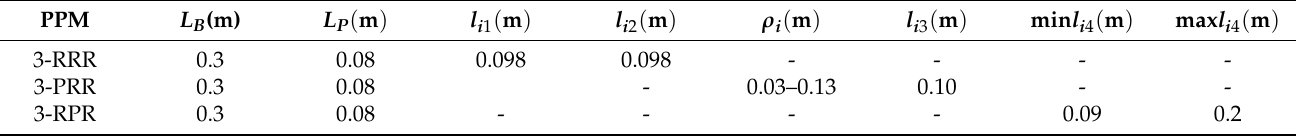
Table 3. The geometric parameters of three PPMs, selected based on the maximum